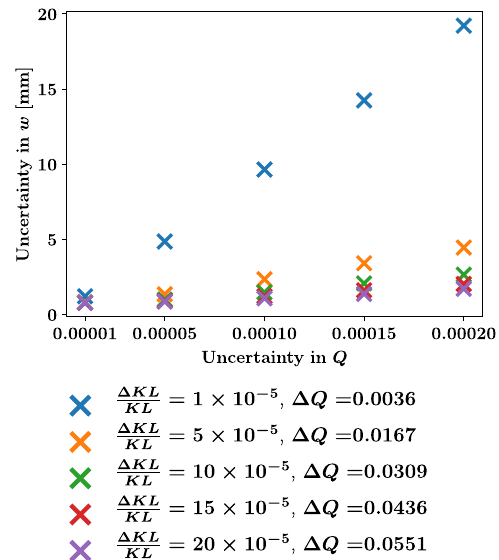
FIG. 10. Uncertainty in the w measurement in LER for different uncertainties in the tune measurement, as well as for different values of modulation strength Δ KL . Simulated for nominal β (cid:1) y ¼ 270 μ m.